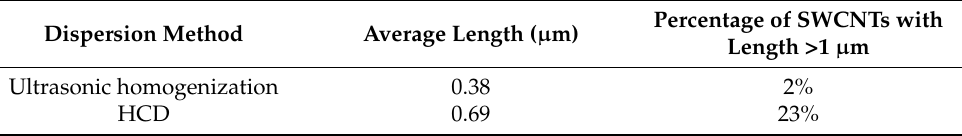
Figure 3. Histogram showing the length distributions of SWCNTs dispersed by using the ultrasonic homogenization (blue) and HCD method (red) with the class interval of 200 nm. Table 1. Effect of the dispersion method on the length and micrometer-long SWCNT content of dispersed SWCNTs.